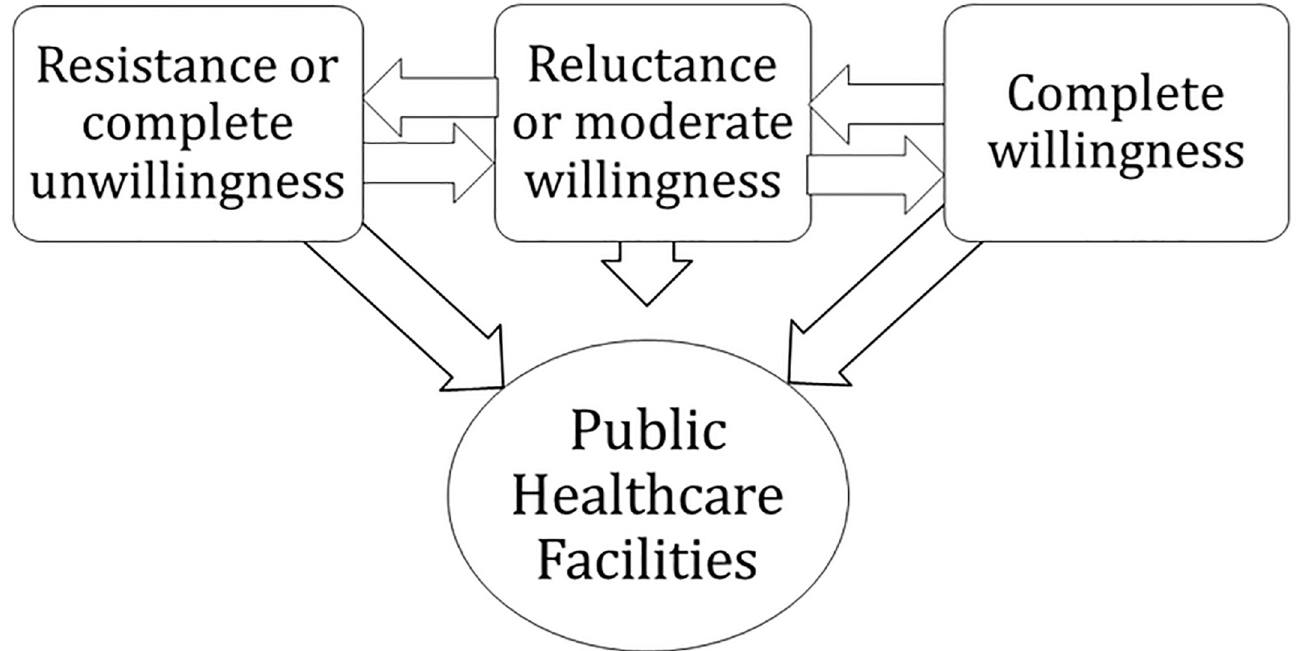
Fig 2. Continuum of community